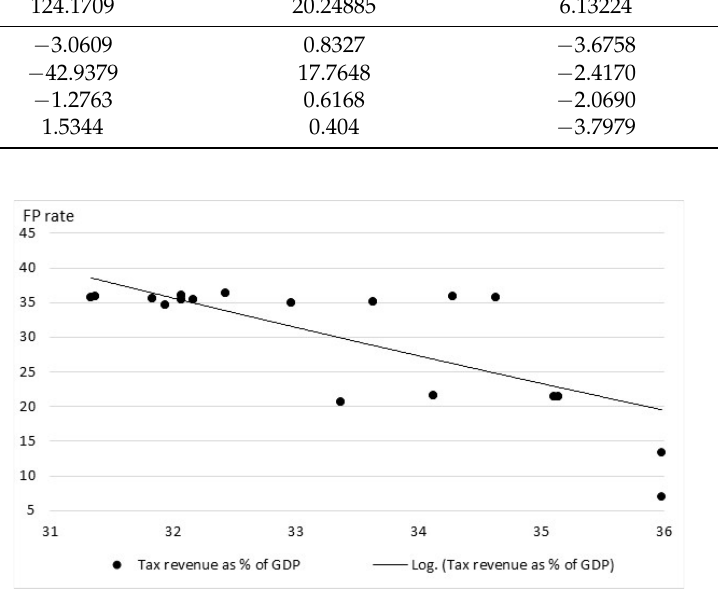
Figure 4. Relationship between fuel poverty rate and tax revenue in Poland in 2004–mid ‐ 2021.